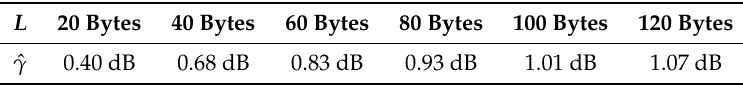
Table A1. Minimum SINRs for IEEE 802.15.4